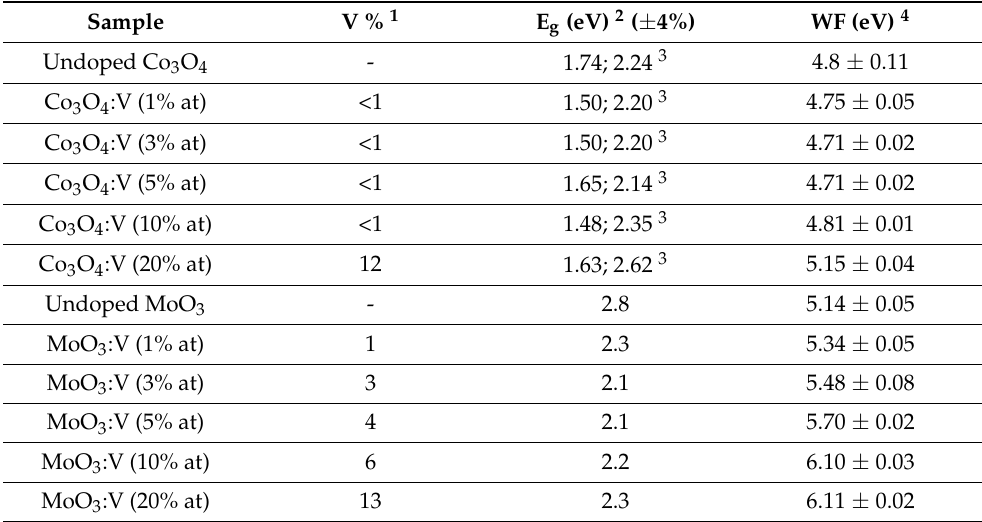
Table 1. Summary of chemical and electrical properties for the series of hydrothermally synthesized undoped and V-doped Co 3 O 4 and MoO 3 samples investigated in the present study.